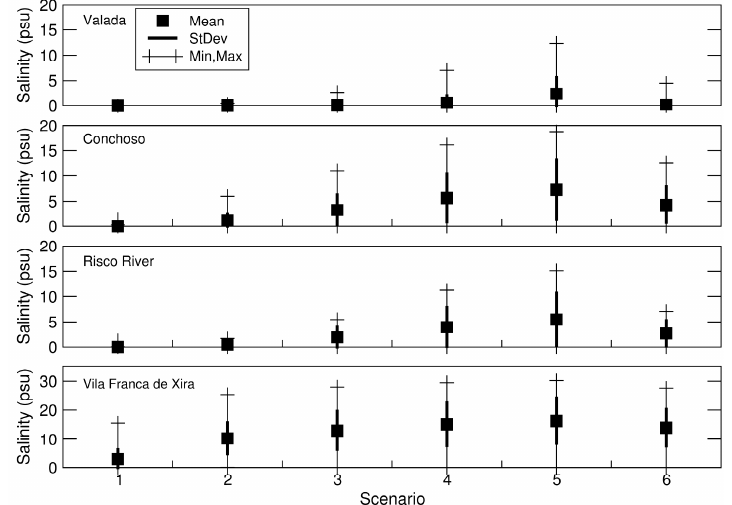
Figure 9. Statistics of surface salinity for the simulated scenarios: S1—climatological, S2—recent drought, S3—worst recent drought, S4—minimum river flow, S5—worst case scenario and S6 – sea level rise. The location of the stations is shown in Figure